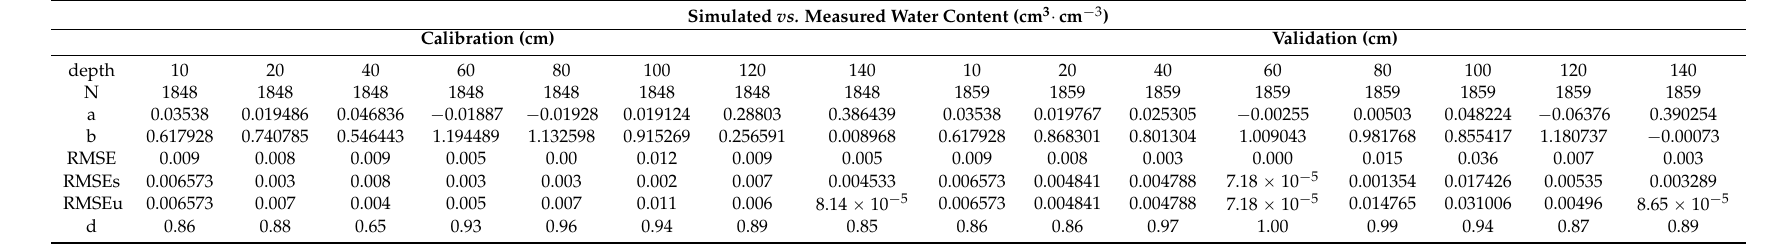
Table 4. Statistical measures of HYDRUS-1D model performance for simulations of volumetric water content.